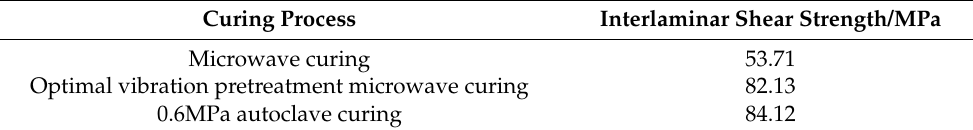
Table 5. Interlaminar shear strength values of composite laminates with different curing processes.